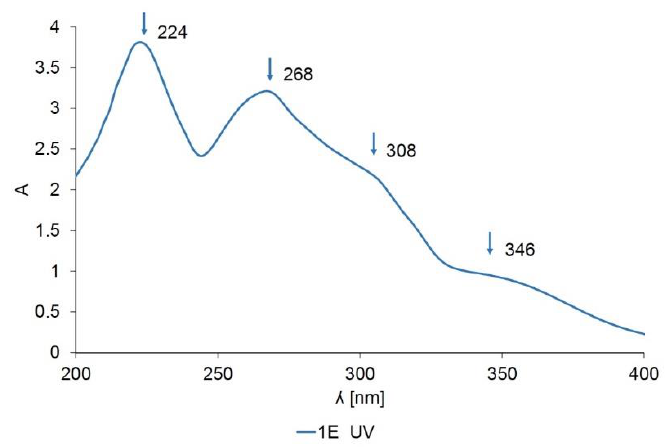
Figure 3. The UV absorption spectra of dye solution 1E.